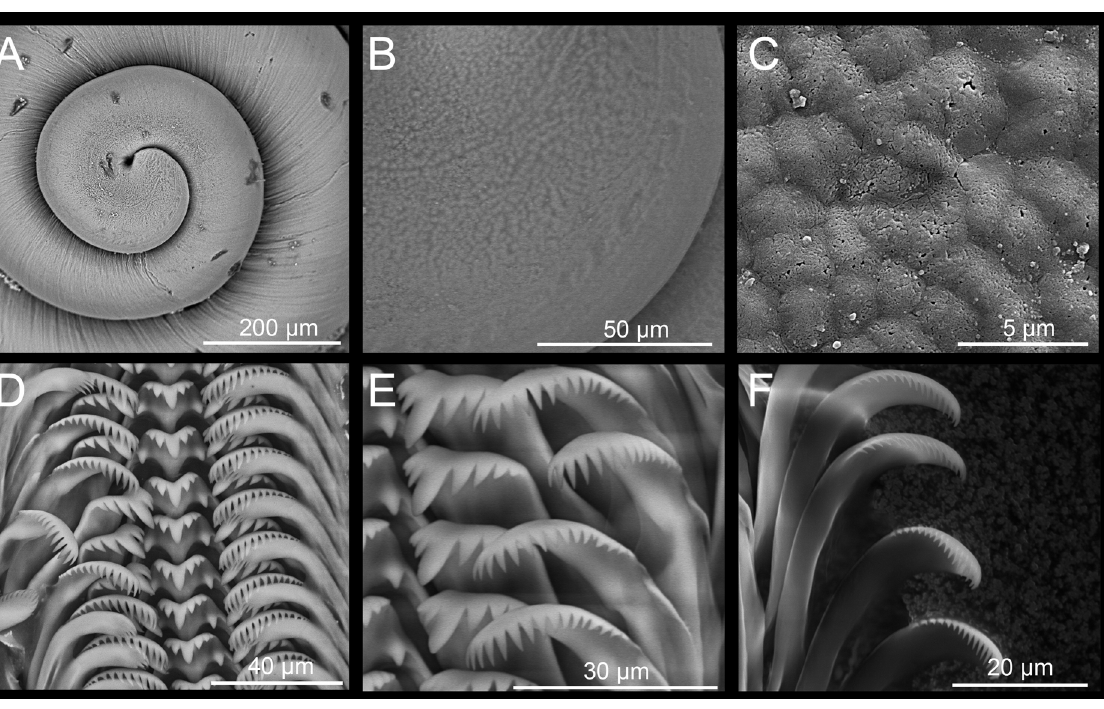
Fig. 12. Protoconch and radula of Mercuria balearica (Paladilhe, 1869). A–C . Venta El Pilar Spring, Málaga, Spain. A . Details of the protoconch. B . Details of the protoconch nucleus. C . Protoconch microsculpture. D–F . Stream at Sant Joan de Carbonell, Minorca. D . Overview of radular teeth rows. E . Rows of lateral and inner marginal radular teeth. F . Detailed view of the outer marginal